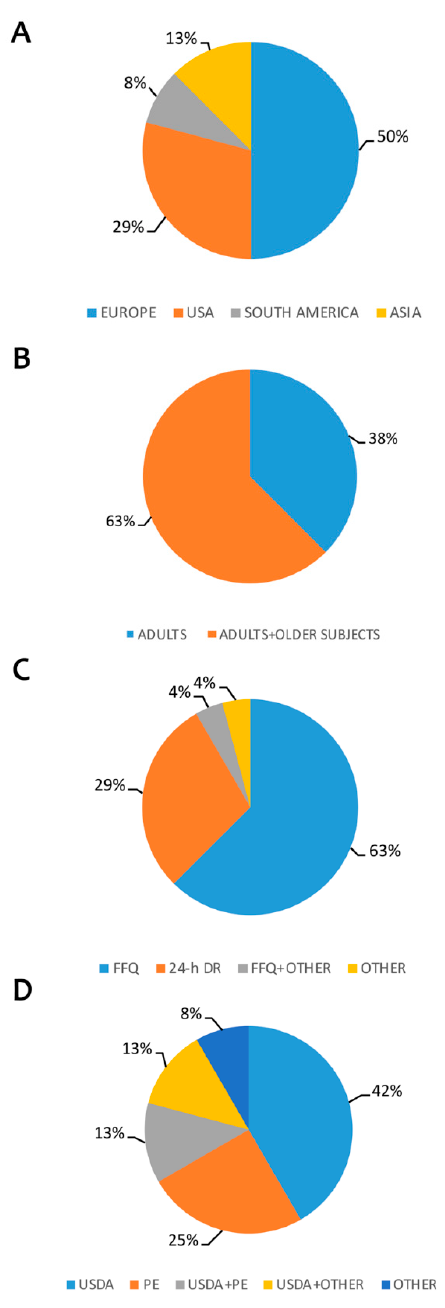
Figure 4. Estimation of polyphenols intake and risk for cardiovascular diseases and diabetes. Legend: ( A ) Distribution of published data by country; ( B ) Target population considered; ( C ) Questionnaires used to evaluate food intake; ( D ) Polyphenol database used for evaluation of intake. FFQ: Food Frequency Questionnaire; 24-h DR: 24-h Dietary Recall; USDA: United States Department of Agriculture; PE: Phenol-Explorer.